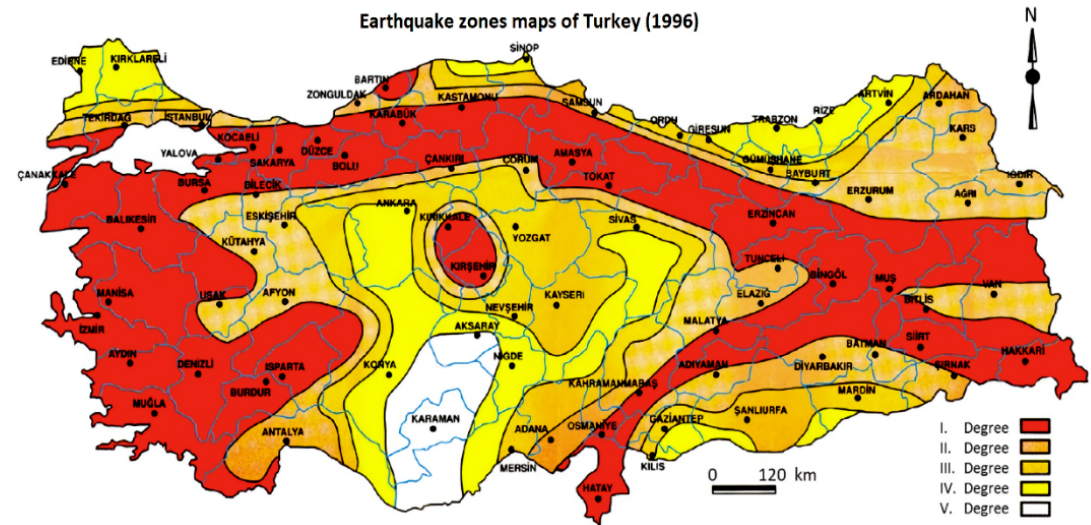
Figure 13. The previous earthquake zone and hazard maps used in Turkey [53]. Within the scope of this study, in order to reveal the effect of the transition from regional to site-specific earthquake hazards on the seismic behavior of masonry minarets, seven different settlements, each one from seven different geographical regions of Turkey, with the same earthquake zone (1. ◦ ) on the previous map were taken into account. The considered settlements are shown in Figure 14.